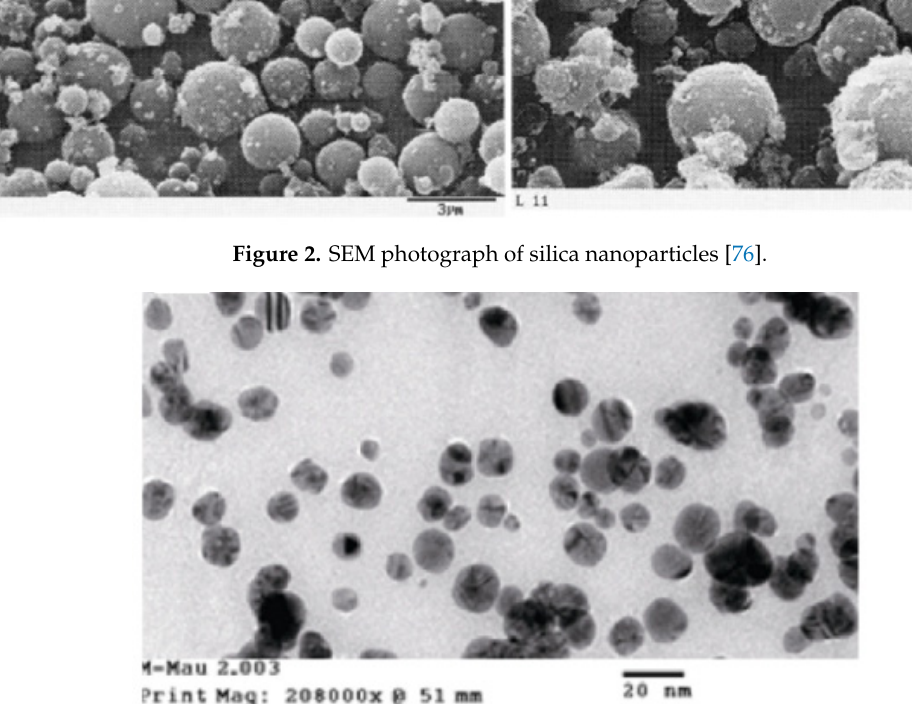
Figure 3. TEM image of silver nanoparticles [82].